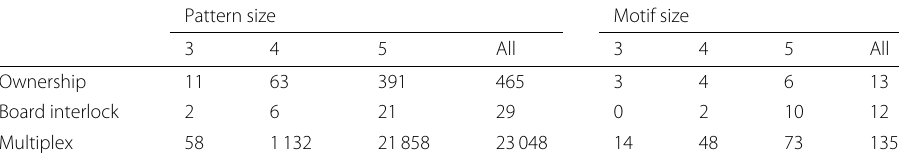
Table 3 Number of discovered patterns and motifs per network Pattern size Motif